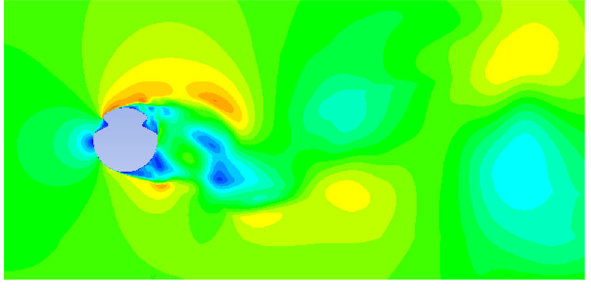
Fig. 7 Karman vortex street of catenary [59]